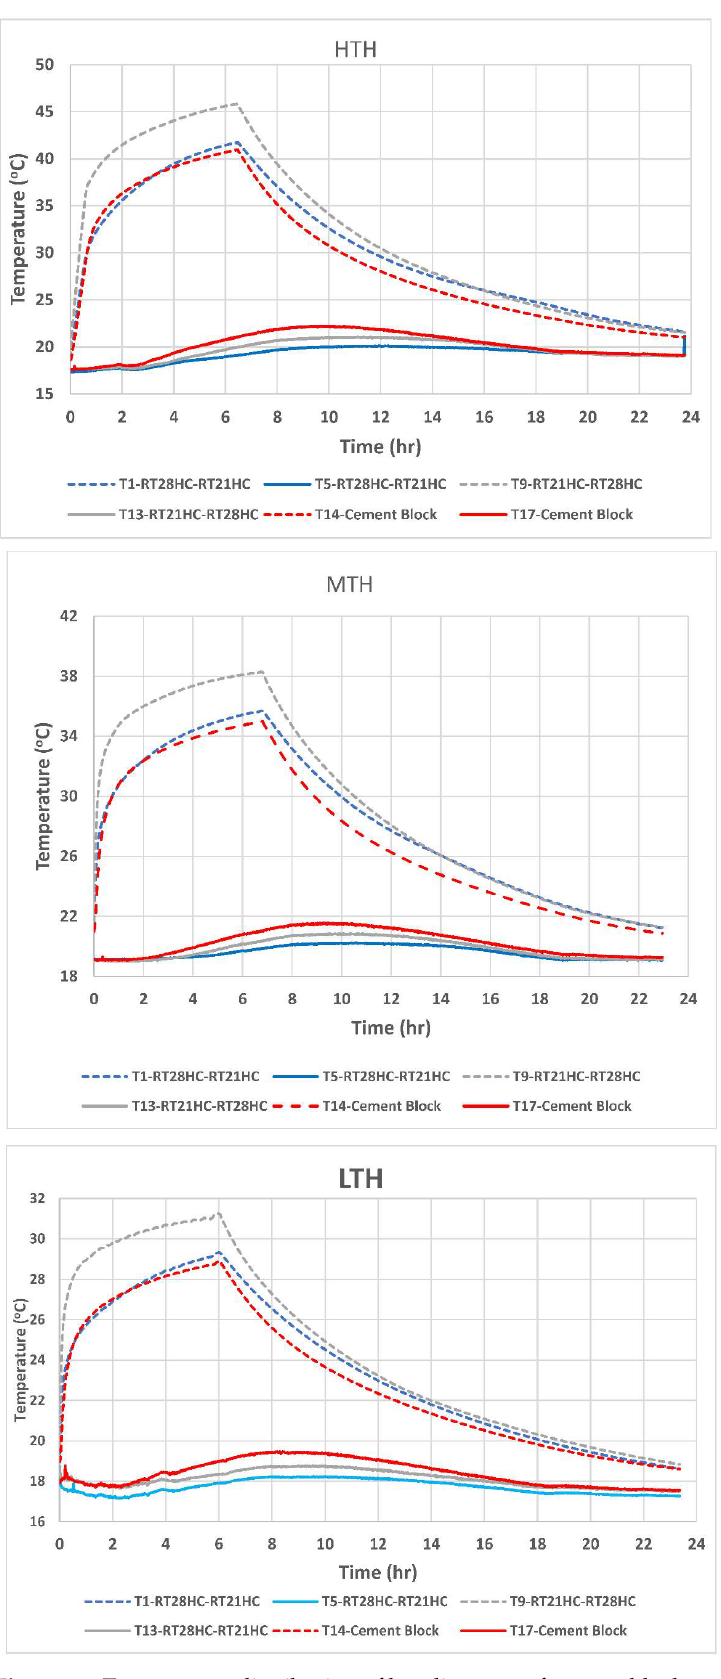
Figure 13. Temperature distribution of baseline case of cement block and PCM RT28HC–RT21HC and RT21HC–RT28HC.